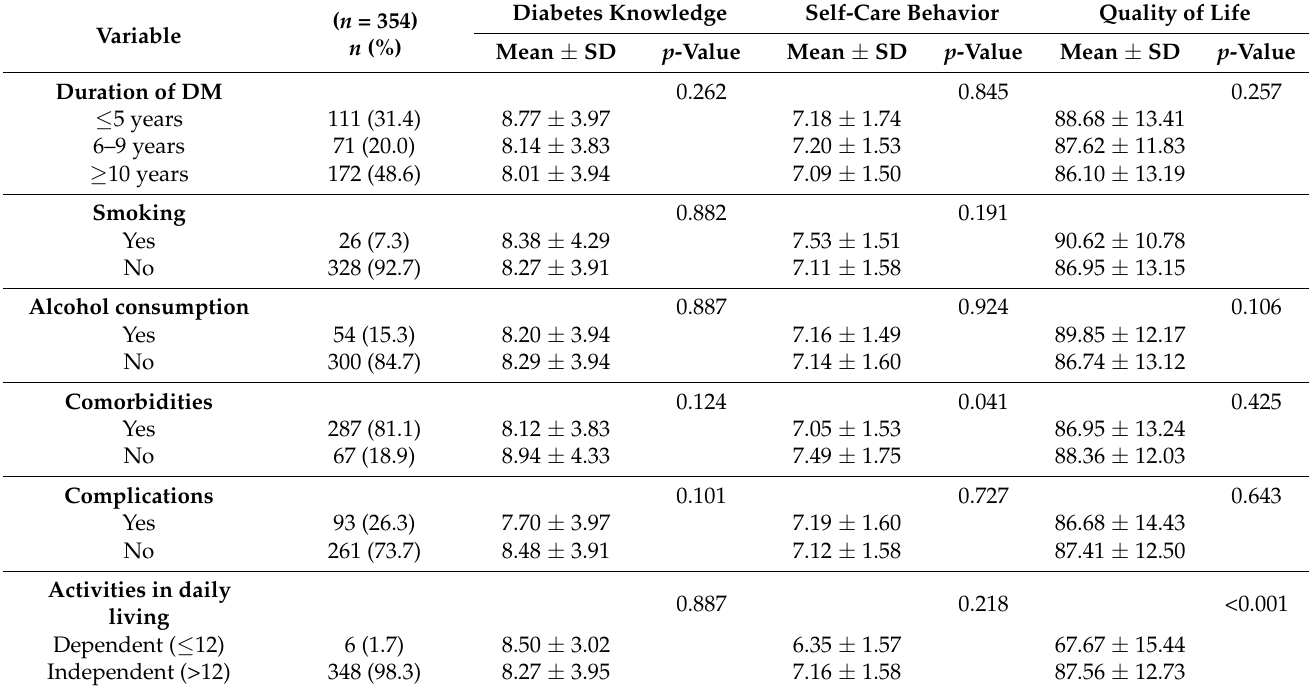
Table 1. emphCont.